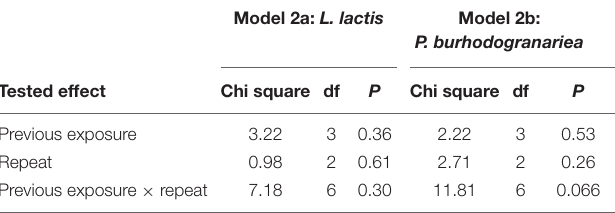
TABLE 1 | The effects of previous exposure and experimental repeat on fly survival for the 7 days post-challenge. Model 2a: L.